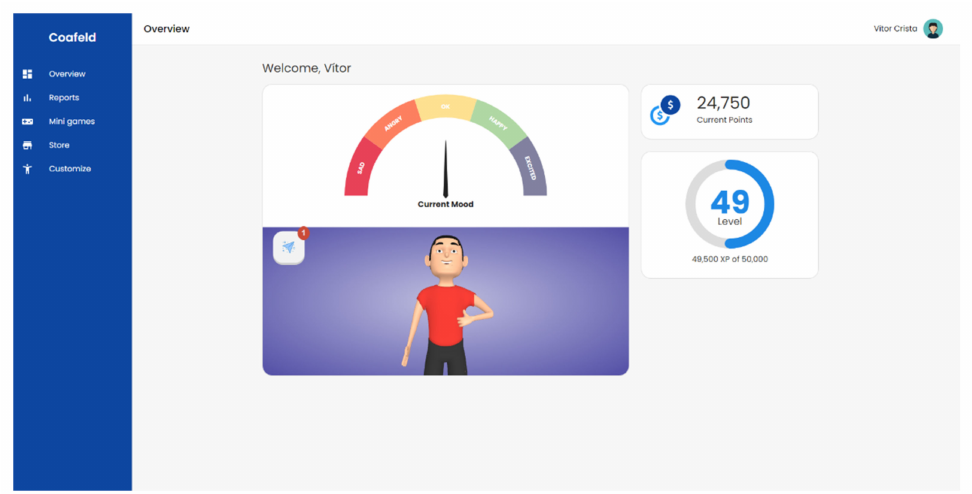
Figure 3. Main page interface. The user can see his/her current progress as well as interact with the cognitive assistant and receive feedback from the system (messages to congratulate/encourage healthier behaviors).